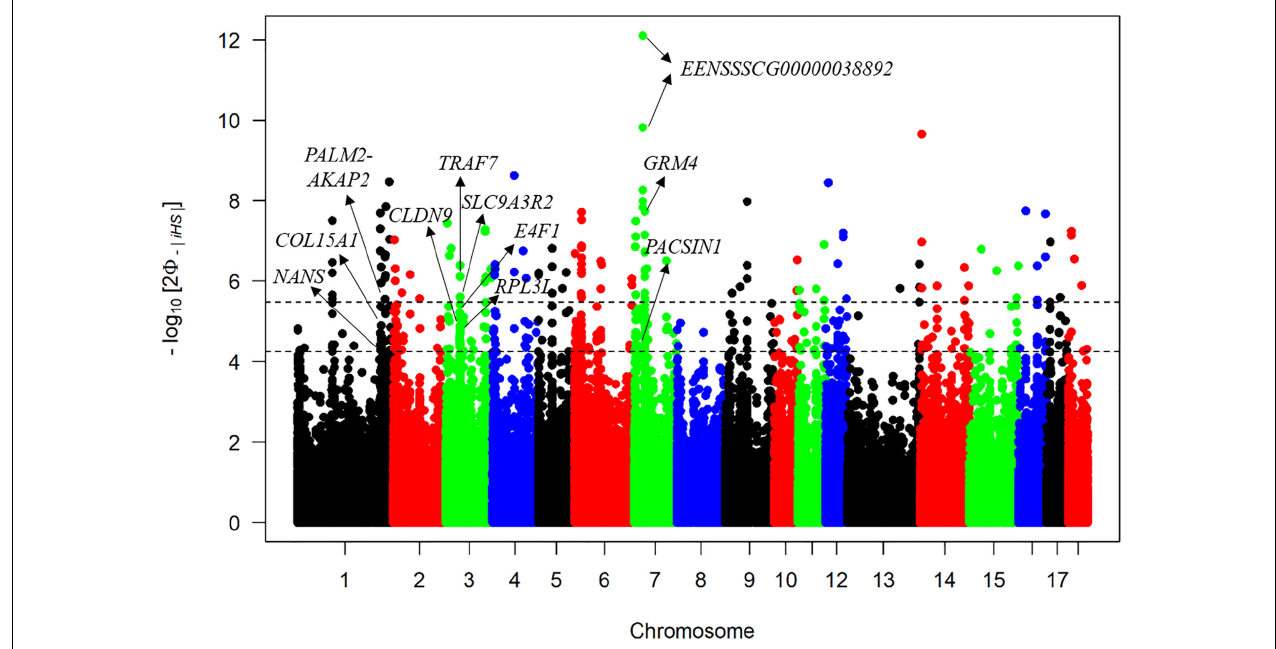
FIGURE 4 | Manhattan plot of iHS test. The x -axis denotes the chromosome position, and the y -axis represents the associated p -value of each |iHS| score. The upper dashed line represents the threshold with q < 0.01, and the lower dashed line represents the threshold with q <